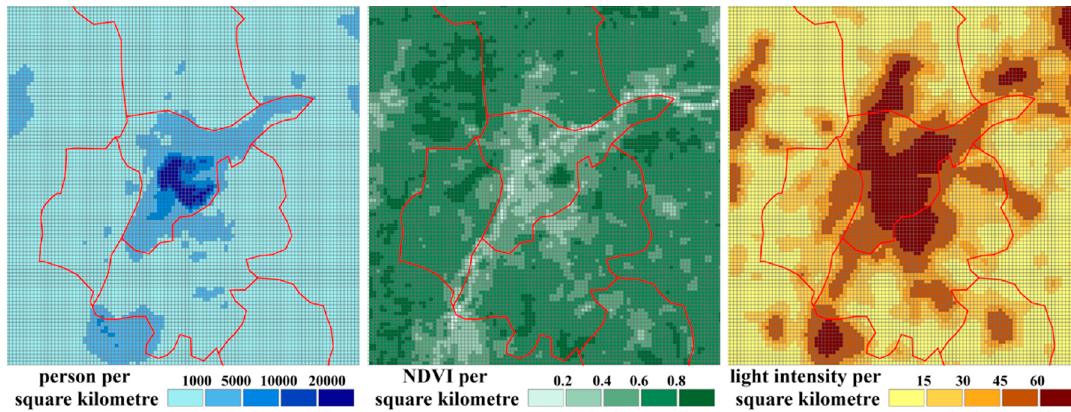
Figure 4. POP, NVDI, and NTL grid data.